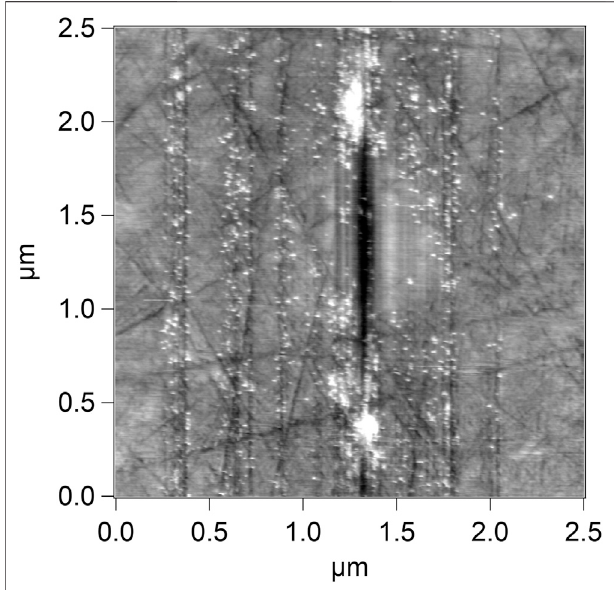
FIGURE 7 | Wear track with nine isolated scratches, some of which run over a carbide in the middle of the image. The Z -scale is ± 8 nm. Numerous small wear particles are sticking mainly close to the grooves and are agglomerated before and after the circular carbide in the